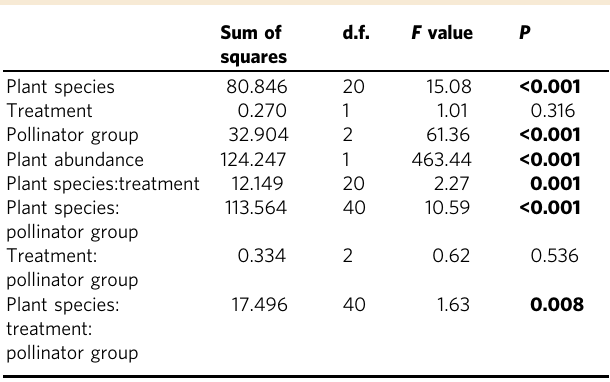
Anova table of the general linear mixed effects model testing for the effect of arti fi cial light at night (control versus illuminated), plant abundance (scaled logarithm), plant species (21 levels), insect group (threelevels:Diptera,Hymenoptera andColeoptera), and theinteractions between treatment and plant species on the number of plant – pollinator interactions (response variable, log-transformed). Estimate values are provided in Supplementary Data 1. P <0.05 are presented in bold. Source data are provided as a Source Data fi